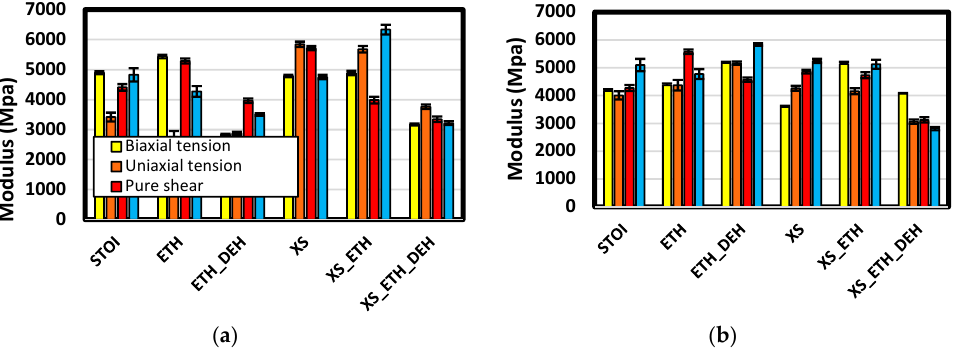
Figure 15. Comparison of zero-strain moduli among various stress states. Charts ( a , b ) are results for short- and long-chain systems, respectively.